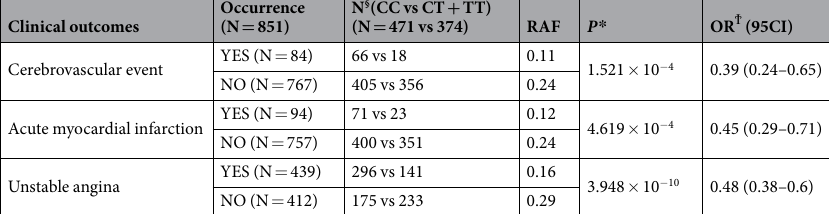
Table 1. The risk allele frequency of acute coronary syndrome patients in three outcome. § Numbers of CC genotype patients vs CT + TT genotype patients who occurred endpoints. * The P value has been adjusted; CI = confidence interval; OR = odds ratio; RAF = risk allele frequency. Ϯ Odds ratio represents the increase in the risk of happening endpoints for each copy of the risk allele compared with subjects who do not carry the risk allele. P values and odds ratios were estimated by